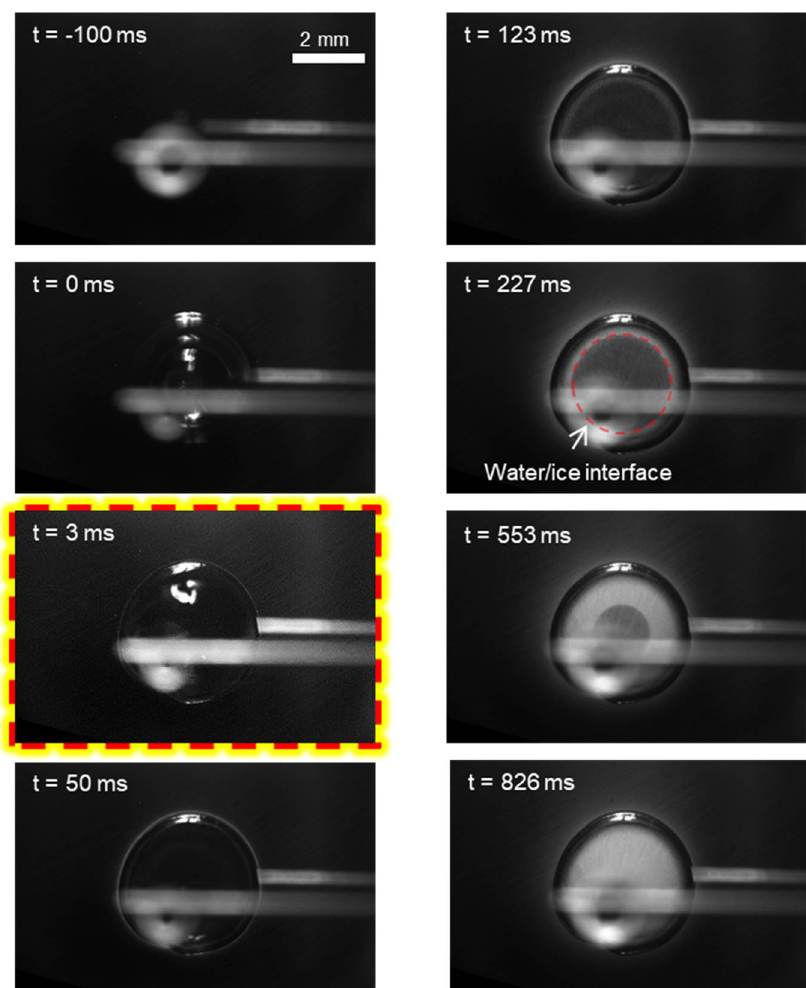
Figure 3. Freezing dynamics of the impinging drop at the substrate temperature of T s = −22.1 ± 0.2 °C, i.e., regime II: spread (incomplete)-freeze. The highlighted capture denotes the onset of icing nucleation.